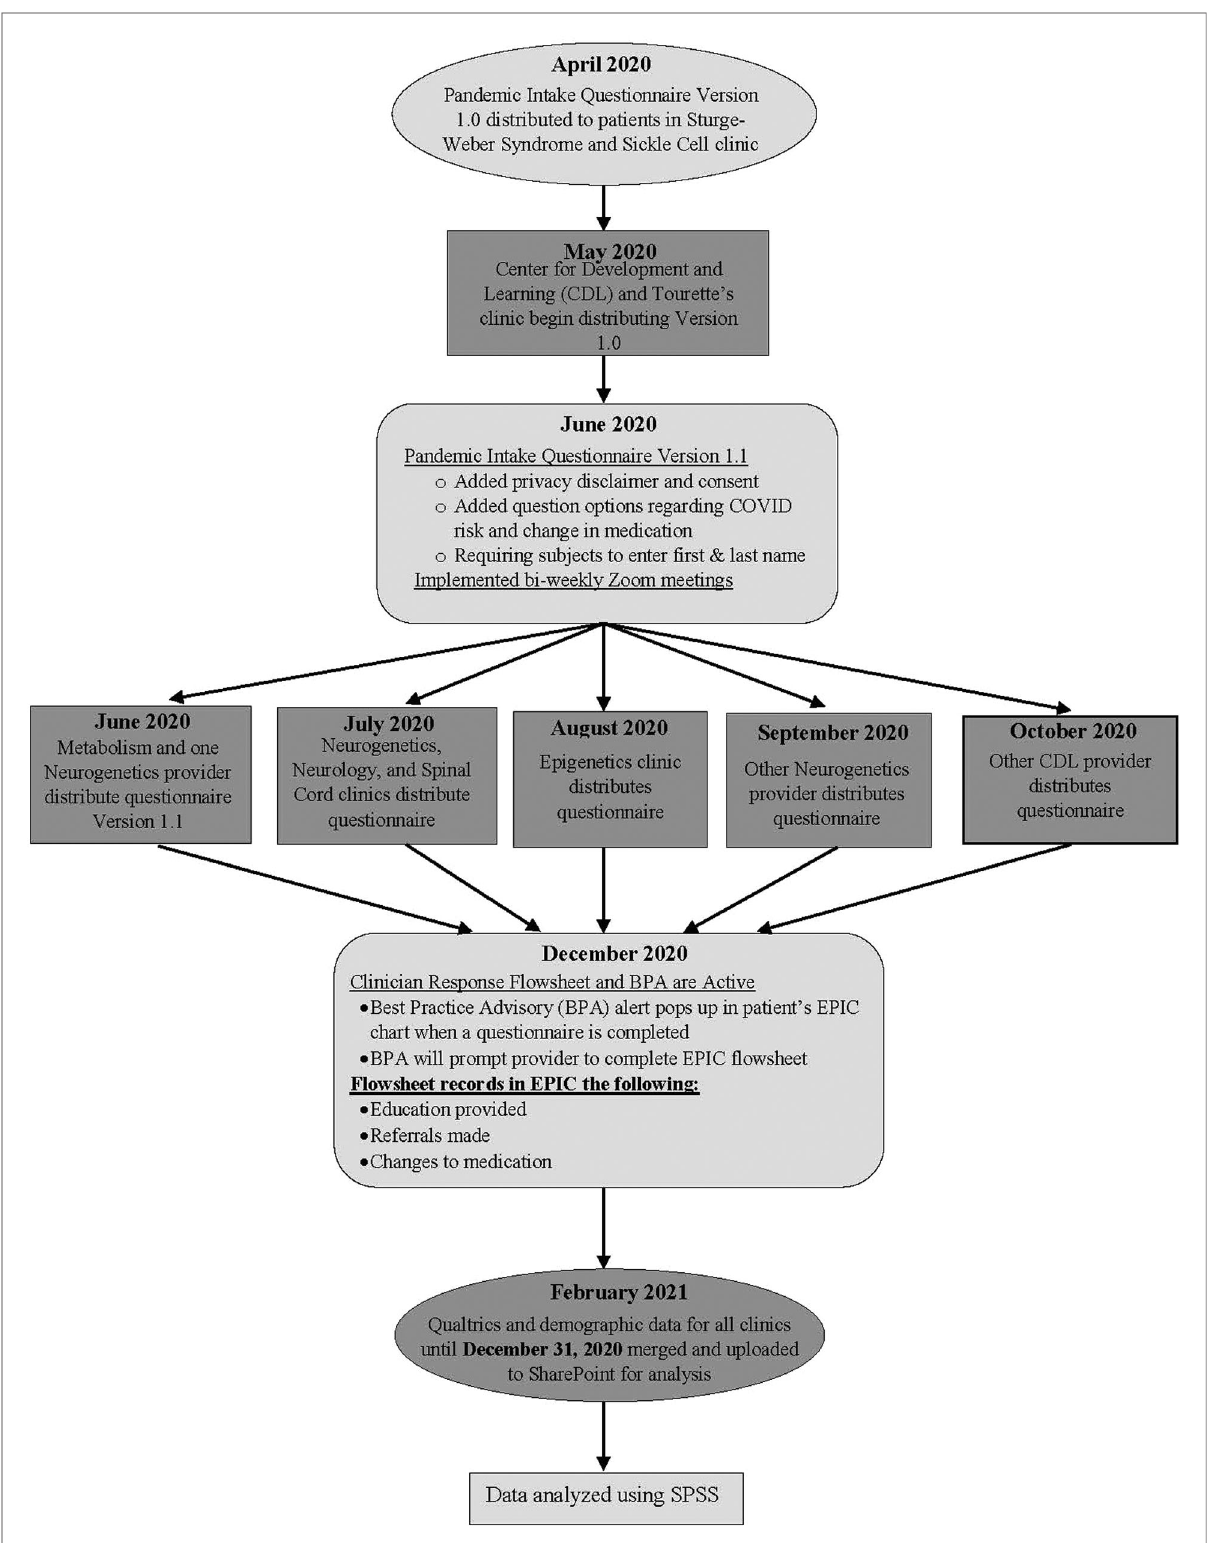
FIGURE 1 Development and implementation of the pandemic intake questionnaire at the institute during the COVID-19